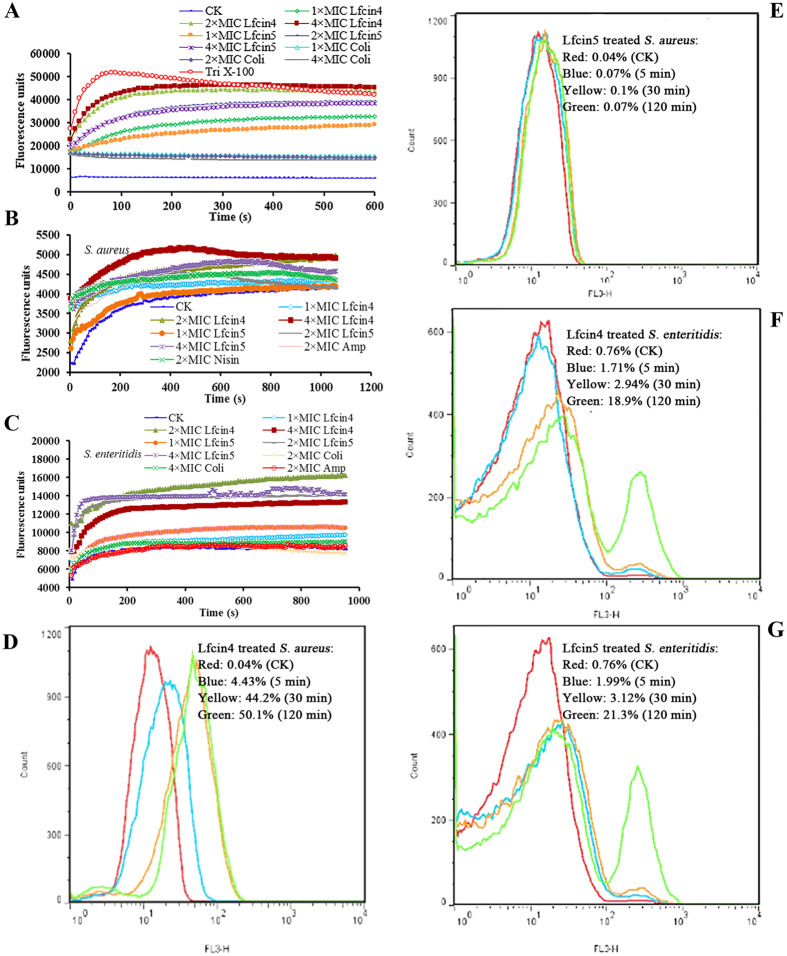
Effects of Lfcin4 and Lfcin5 on the biological membrane.(A) Leakage from POPC/POPG (1:3) vesicles induced by different concentrations of Lfcin4 and Lfcin5. Large unilamellar vesicles (LUVs) loaded with calcein were incubated with Lfcin4 and Lfcin5 and leakage of calcein was monitored for 10 min on a Tecan Infinite M200 PRO plate reader. (B,C) Time-response curve of the outer membrane permeabilization of S. aureus ATCC25923 (B) and S. enteritidis CVCC337 (C) cells treated with Lfcin4 and Lfcin5 in the presence of NPN. PBS treatment was used as a negative control. Treatment with ampicillin and colistin were used as positive controls. Amp: ampicillin; Coli: colistin. (D–G) Fluorescence-activated cell sorting (FACS) analysis of PI staining in S. aureus ATCC25923 (D,E) and S. enteritidis CVCC337 (F,G) cells treated with Lfcin4 (D,F) and Lfcin5 (E,G).